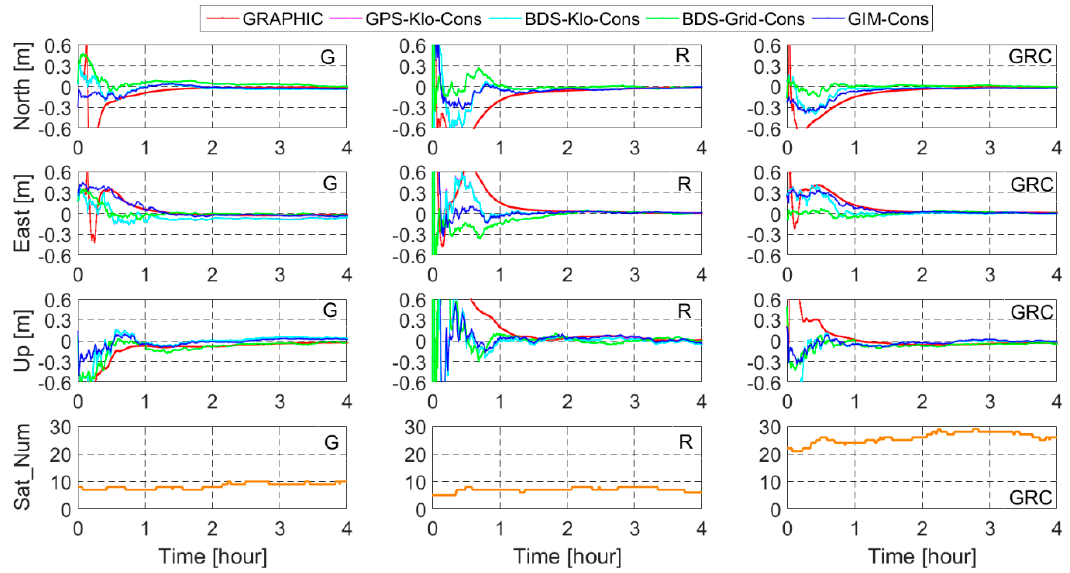
Figure 5. Comparison of positioning error of b1 SF-PPP with di ff erent schemes for GPS, GLONASS and GPS + GLONASS + BDS solutions at QHGC station (DoY 35 in 2019, sum of Kp = 1.25, F10.7 = 71 sfu). The corresponding satellite numbers are represented by the yellow curve. The abbreviation “Cons” represents “Constrained”.